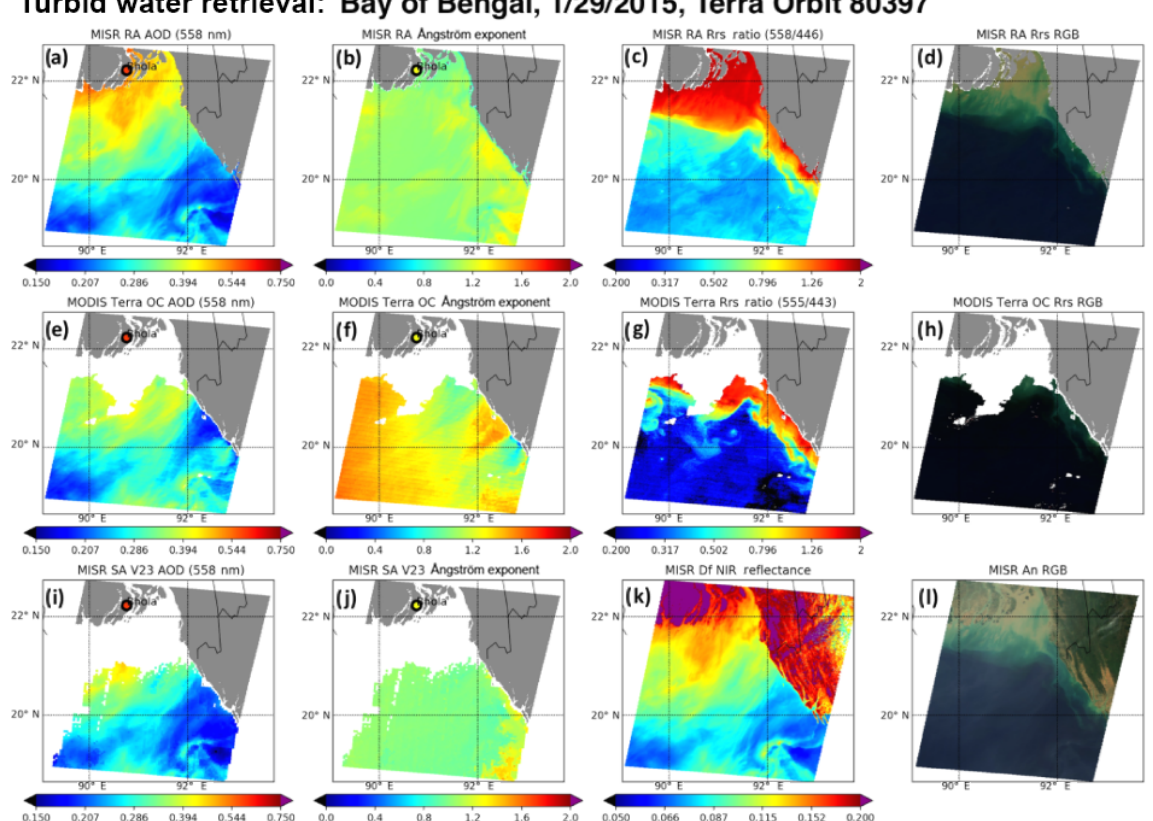
Figure 2. Same as Fig. 1, except for turbid water found in the northern Bay of Bengal. MISR imagery acquired on 29 January 2015, 04:36Z: Terra Orbit 80397, blocks